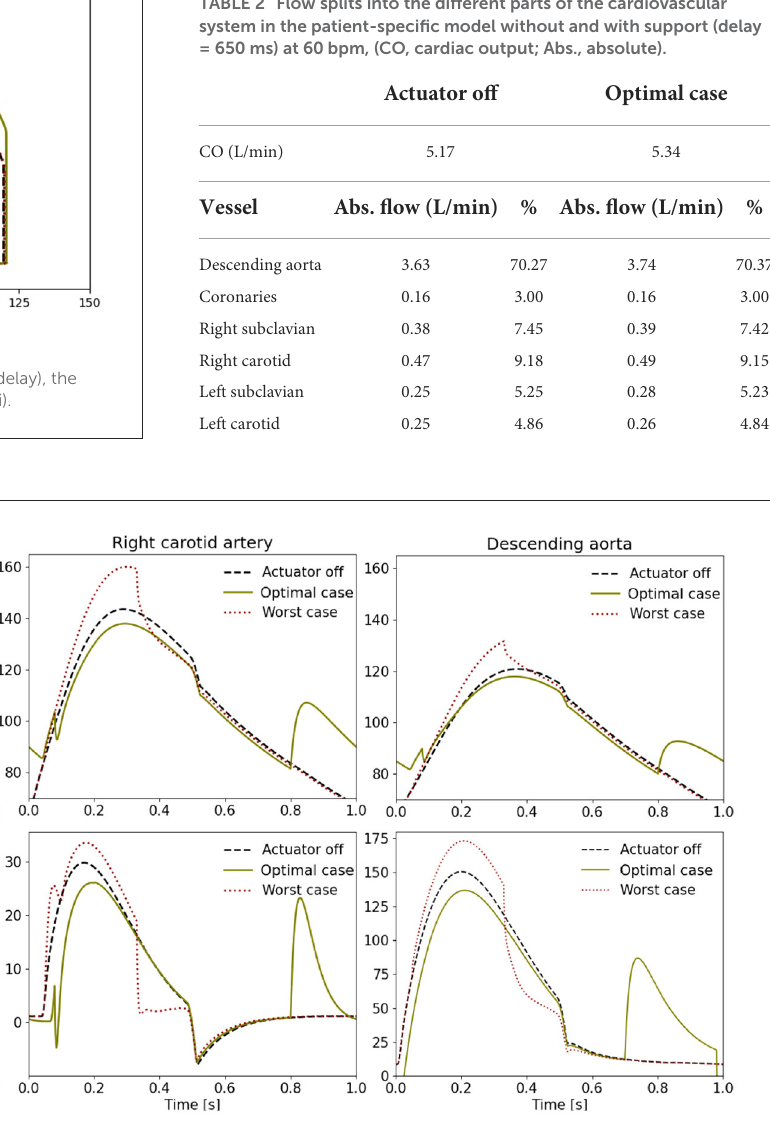
FIGURE7 Pressure and flow waveforms in the coronary and carotid arteries and the descending aorta ( p act = 12 psi). All the measurements presented in this figure are made at the interaction of the last vessel element of the branch of interest and its proximal RCR